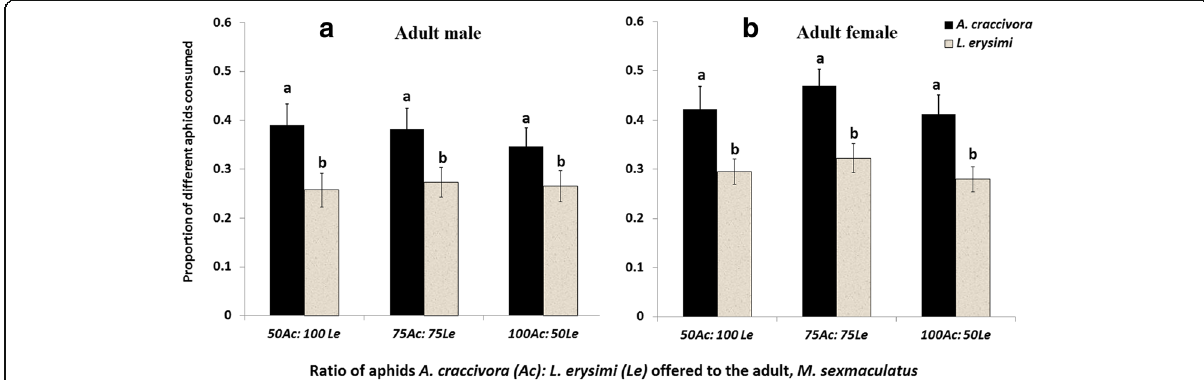
Fig. 2 Proportions of aphid species [ A . craccivora (Ac) and L . erysimi (Le) reared on R . sceleratus and B . campestris , respectively] consumed by adult a male and b female of M . sexmaculatus when the aphids were provided in different ratios . Error bars show standard error. Bars indicated by the same letter are not statistically different at P < 0.05 (Tukey ’ s